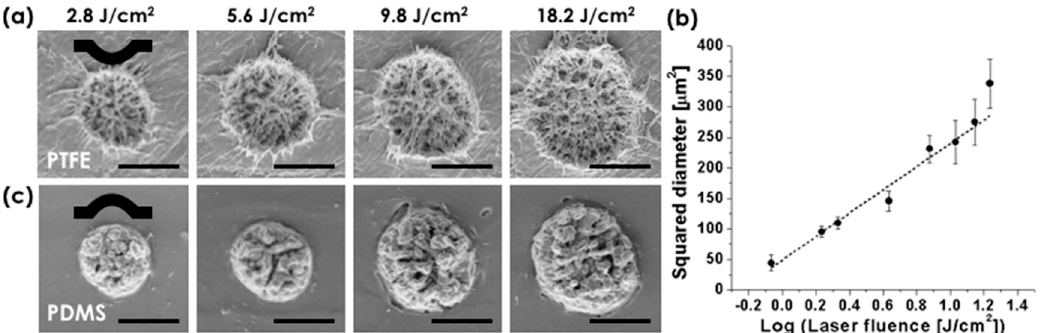
Figure 1. Single laser pulse ablation of polytetrafluoroethylene (PTFE) and process producing numerous polydimethylsiloxane (PDMS) replica: ( a ) scanning electron microscopy (SEM) pictures of ablated PTFE surface under varied laser fluence; ( b ) The squared diameter ( D 2 ) of the ablated PTFE spot is plotted as a function of the laser fluence in log scale; ( c ) SEM pictures of PDMS replica from the ablated PTFE surface ( a ). The scale bars are 10 μ m.